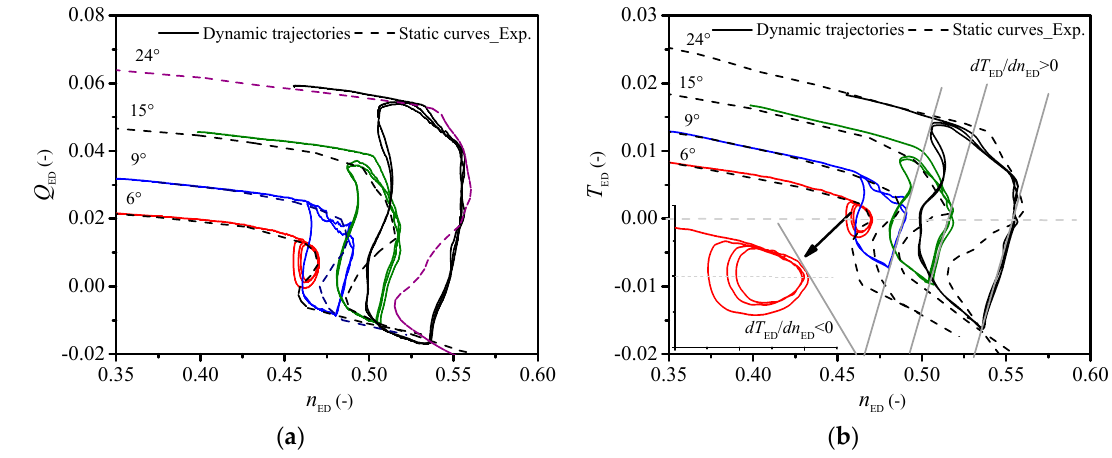
Figure 3. Dynamic trajectories and static characteristic curves. ( a ) n ED – Q ED ; ( b ) n ED – T ED .